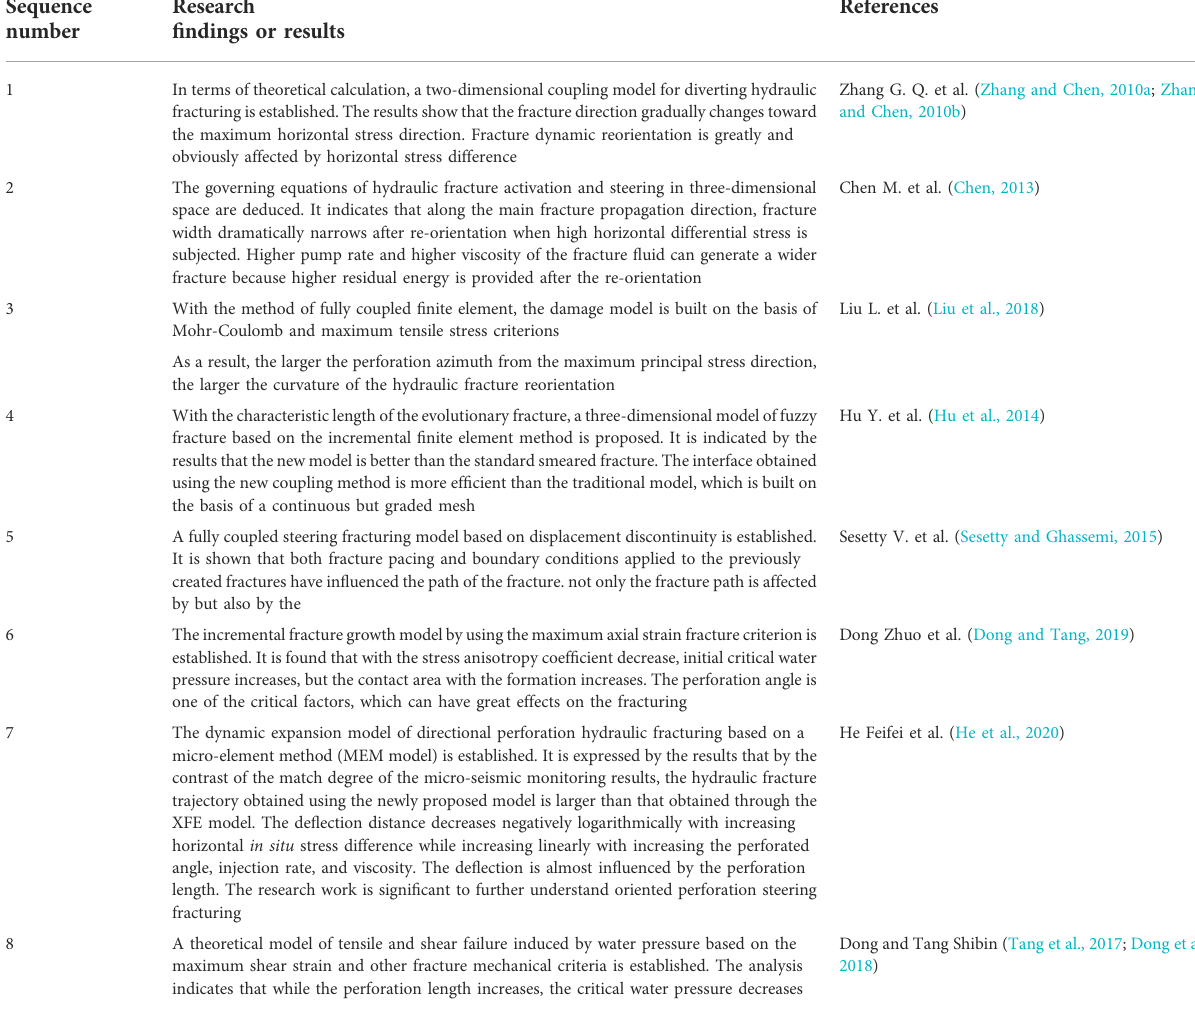
TABLE 1 Summary of the existing analytical models and empirical